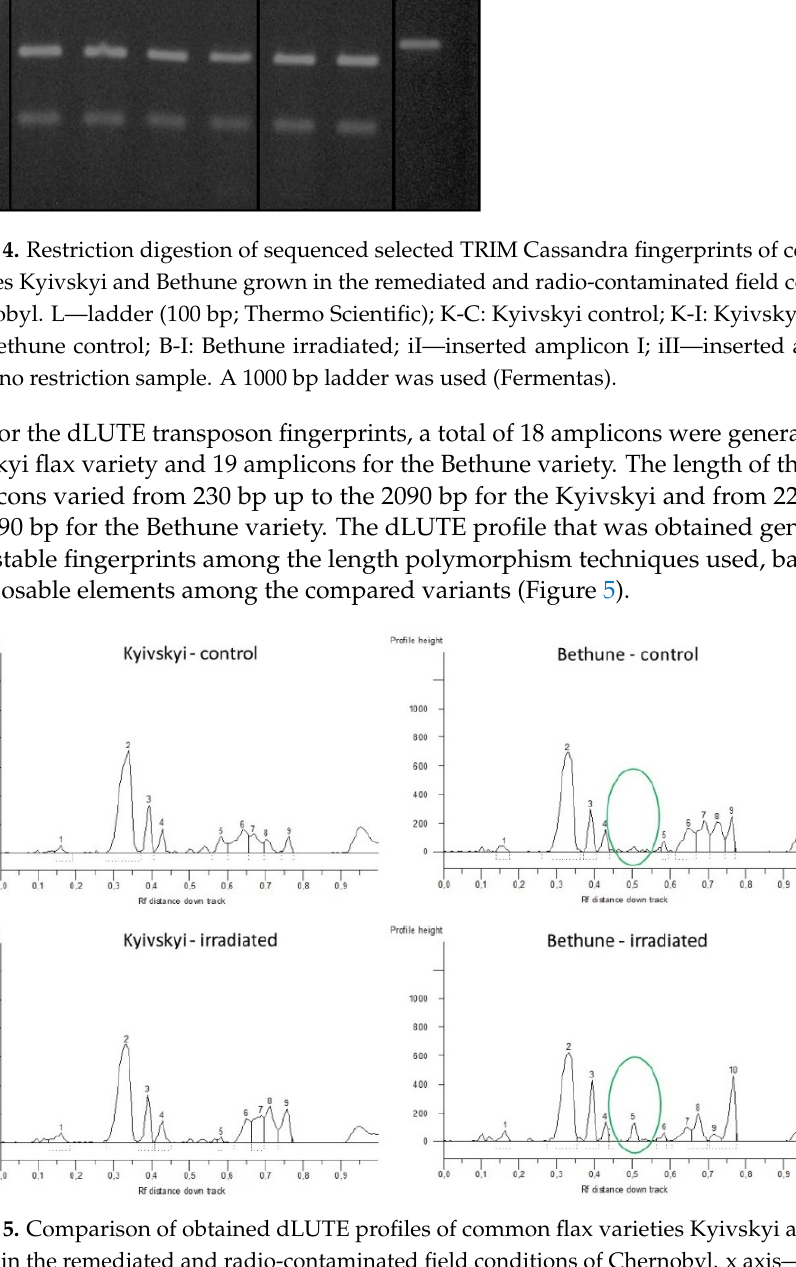
Figure 3. Sequence alignment by Clustal Omega of Cassandra amplicons generated in selected TRIM Cassandra fingerprints of common flax varieties Kyivskyi and Bethune grown in the remediated and radio-contaminated field conditions of Chernobyl.